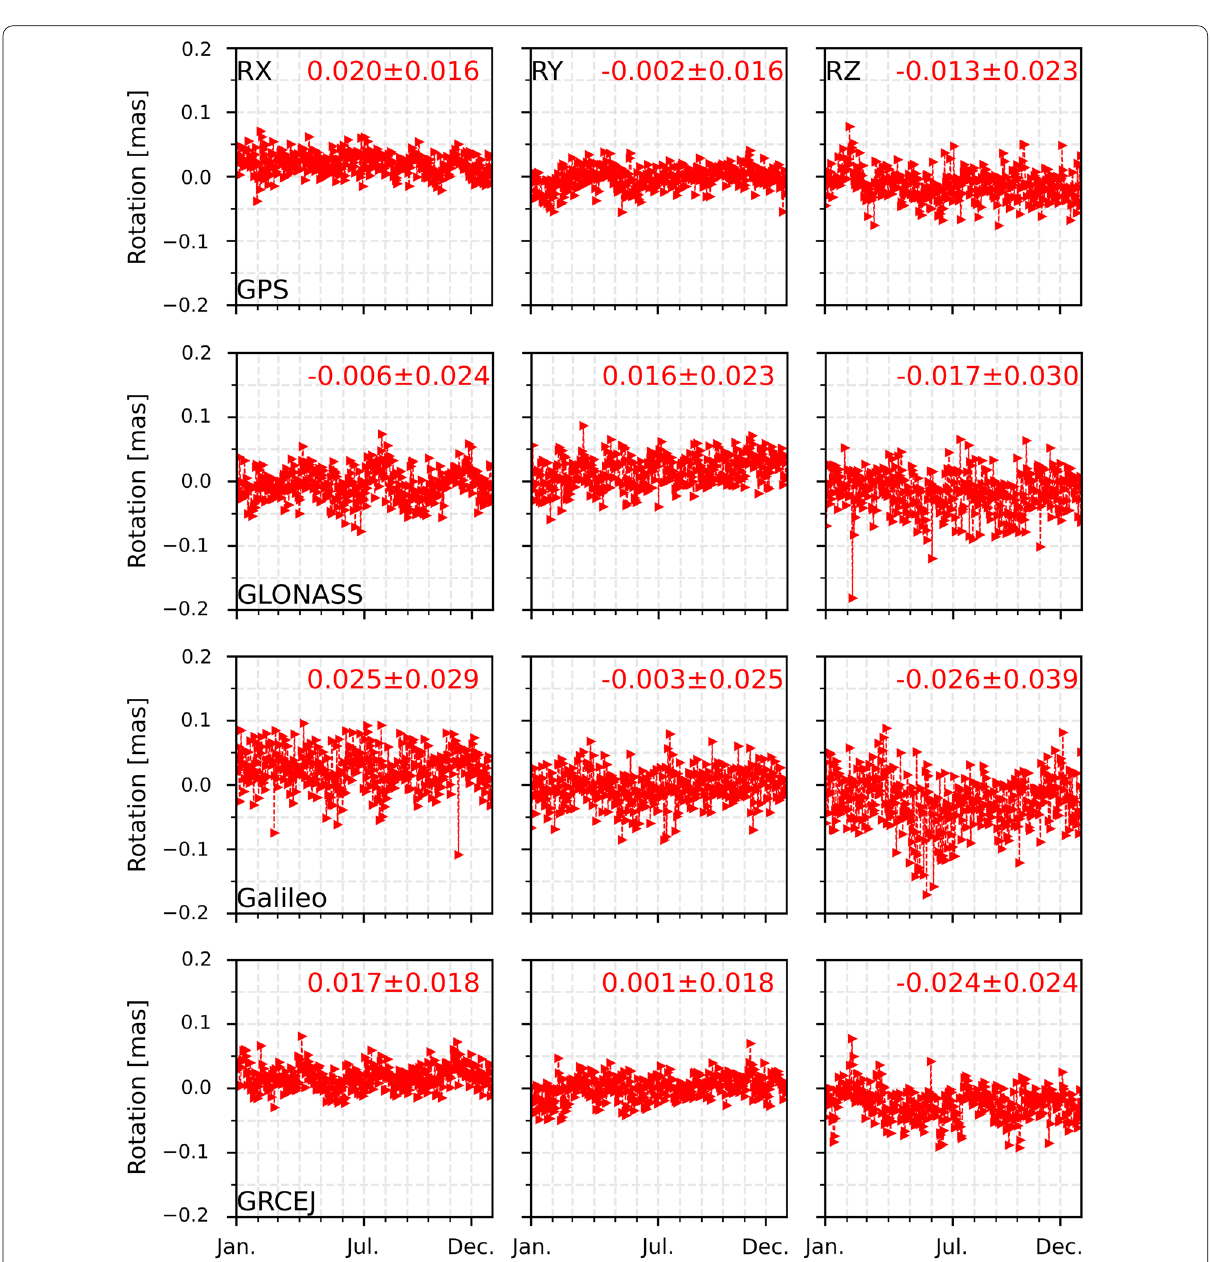
Fig. 10 Rotations of PPP solutions determined with combined orbit and clock solutions with respect to that of the IGS final